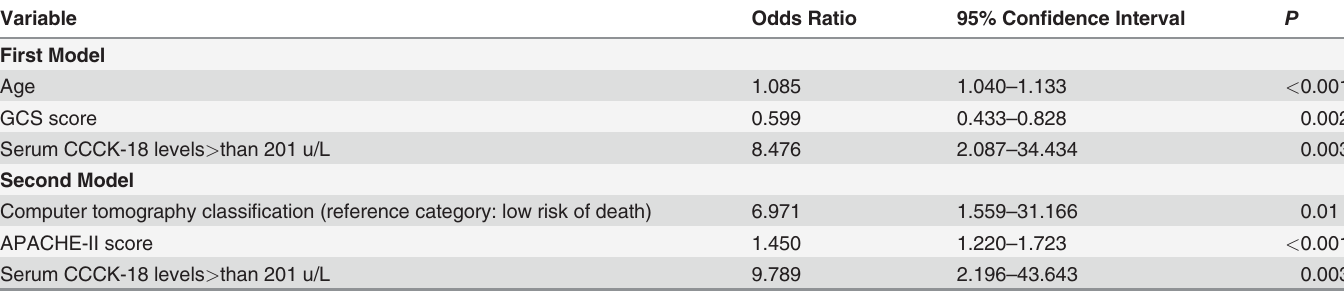
Table 3. Multiple binomial logistic regression analysis to predict 30-day